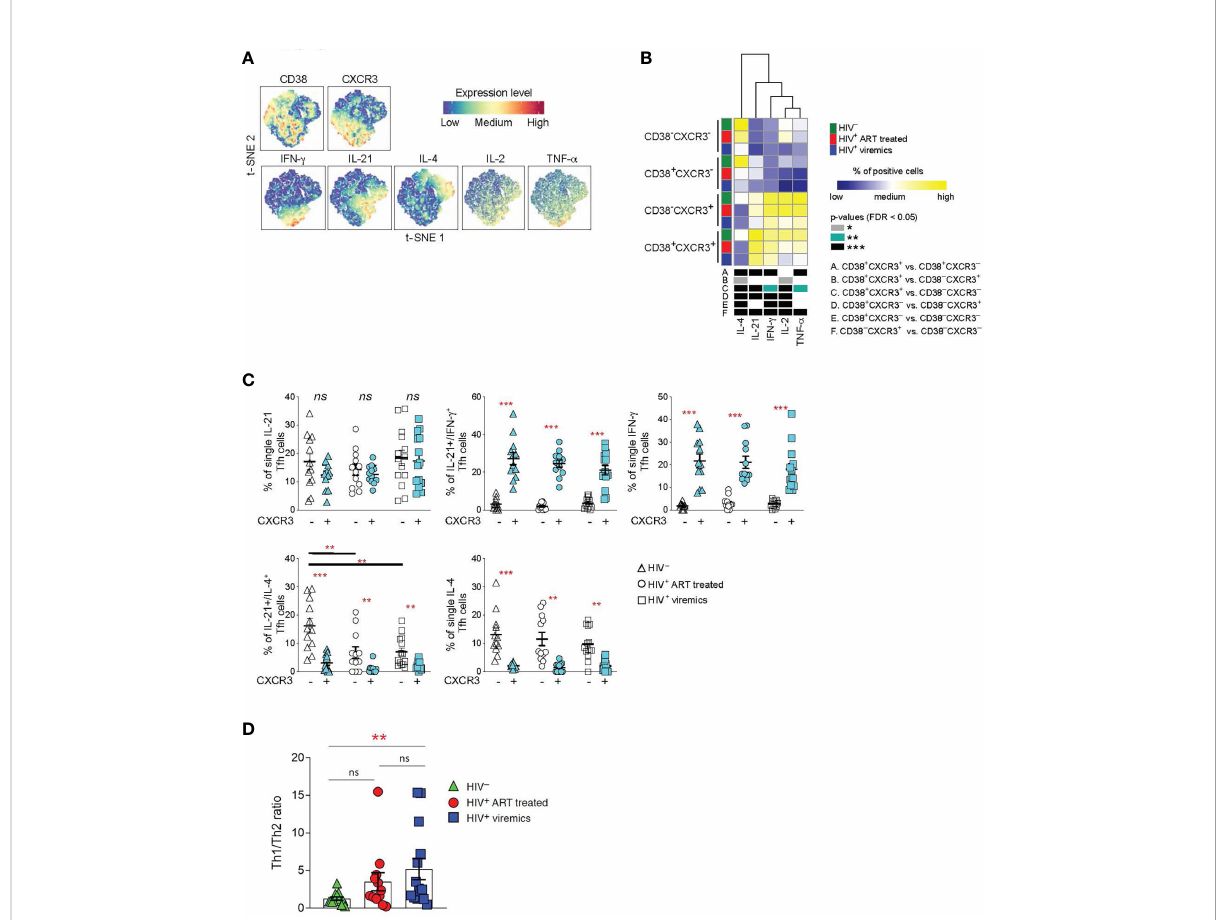
FIGURE 3 Functional analyses of Tfh cells on the basis of CD38 + and CXCR3 + expression. LNMCs were isolated from HIV uninfected (N = 12), HIV-1 infected HIV-infected ART treated individuals individuals (N = 12) and HIV-infected viremic individuals (N = 14) and stimulated with PMA- ionomycin for 5 hours and stained with antibodies against PD-1, CXCR5, CD38, CXCR3, IFN- g , IL-21, IL-4, IL-2 and TNF- a . (A) t-SNE plot of pooled Tfh cells from the three study groups (51 ’ 171 cells). (B) Heat map of scaled mean marker expression (percentage of producing cytokines) in Tfh cells gated on the basis of CD38 and CXCR3. The bottom panel shows signi fi cant differences between subsets of cells for all possible comparisons. (C) Simultaneous analysis of the functional pro fi le of CXCR3 - and CXCR3 + Tfh cells on the basis of IL-21, IL-4 and IFN- g production. (D) Th1/Th2 ratio in Tfh cells from HIV uninfected, HIV infected viremic and HIV-infected ART treated individuals individuals. Ratio was calculated by dividing the frequencies of IFN- g producing Tfh cells and the frequencies of IL-4 producing Tfh cells in HIV- and HIV HIV- infected viremic individuals. In (B) differences between subsets were calculated on all cohort samples using linear mixed-effect models and P values were corrected using FDR method with a cutoff of 0.05. In (C, D) P values were obtained by a Mann-Whitney test to compare the three study groups and a Wilcoxon signed-rank test to compare frequencies between CXCR3 - and CXCR3 + populations. * P < 0.05, ** P < 0.01, *** P < 0.001. Error bars denote mean ± S.E.M. ns, not signi fi